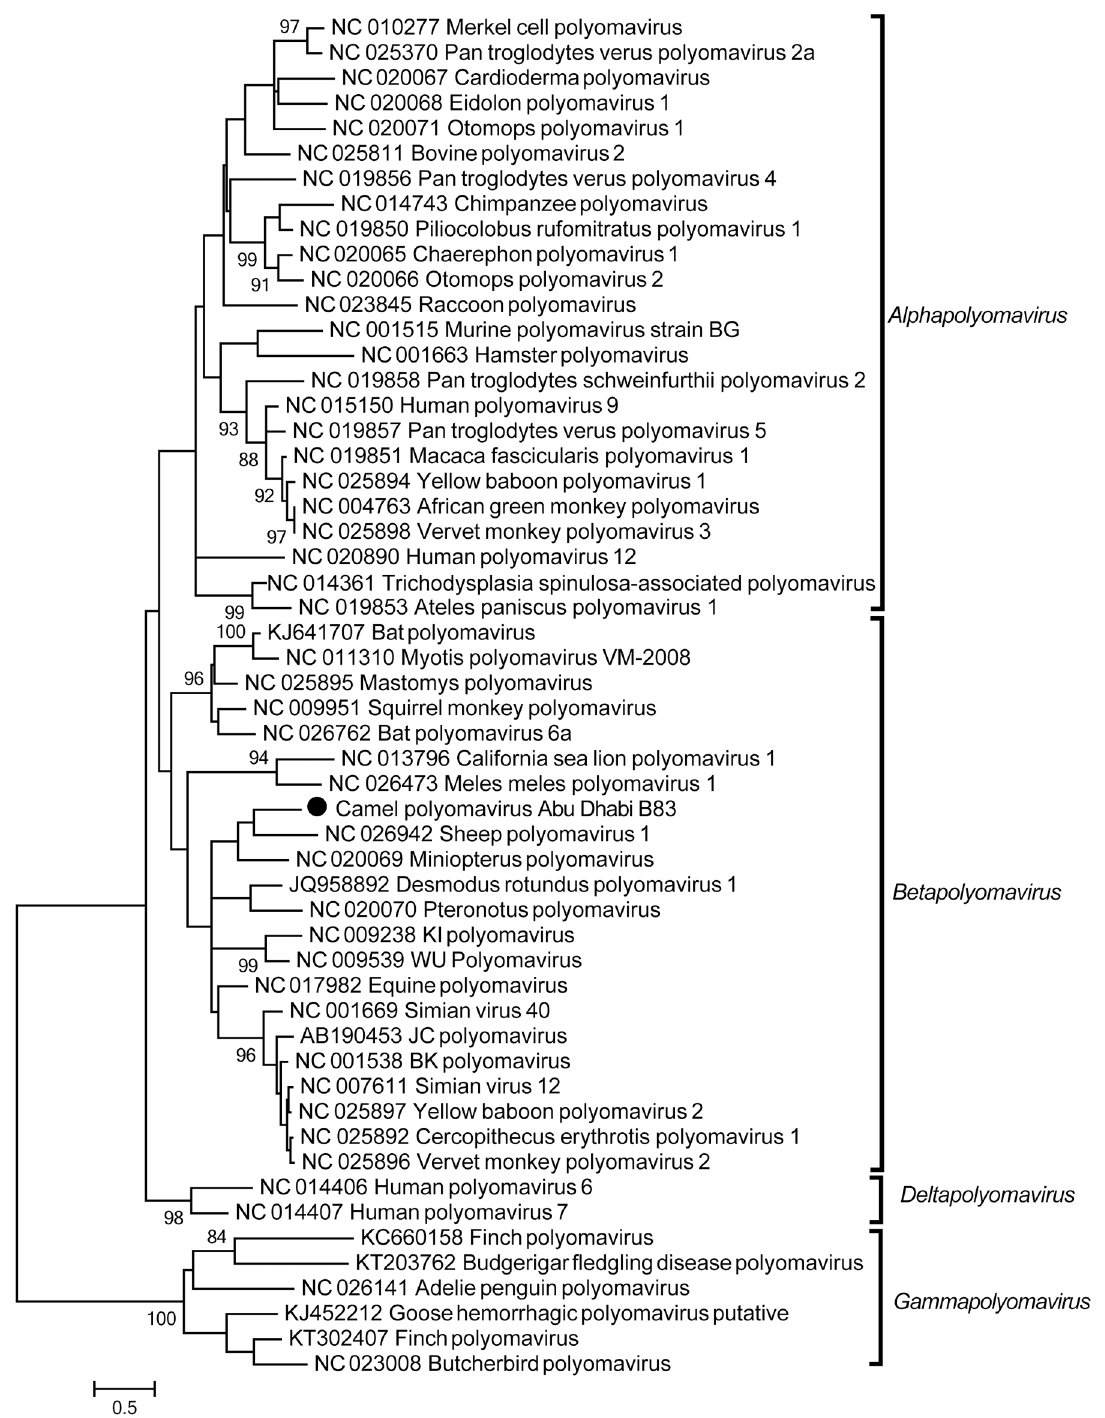
Fig 6. Phylogenetic analysis of camel polyomavirus Abu Dhabi. Maximum likelihoodphylogenetic tree was estimated from the longest contiguous large T antigencoding sequence(384 nt) obtainedand 53 previously published polyomavirus large T antigensequences. The four generain Polyomaviridae are labeledaccordingly. The camel polyomavirus sequence identifiedin this study is highlightedby a solid circle. The scale bar indicatesthe estimated number of nt substitutions per site and the bootstrapvalues ( (cid:21) 80) are